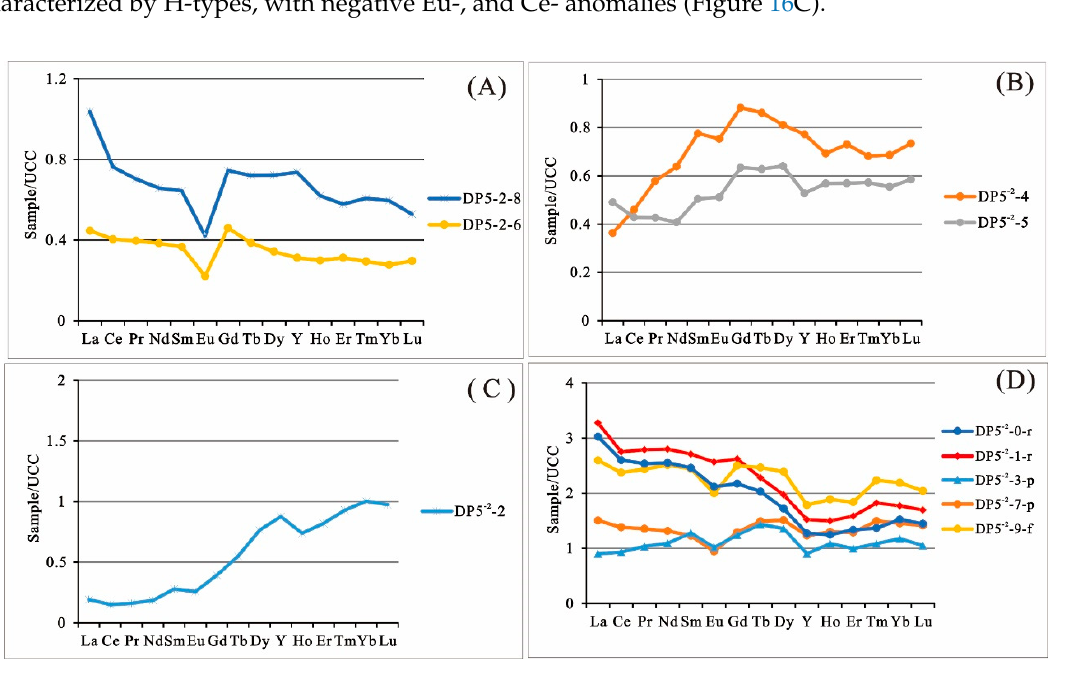
Figure 16. Distribution patterns of rare earth elements and yttrium of the Dongpo Mine samples. REY concentrations are normalized to Upper Continental Crust (UCC) [69]. ( A ) Distribution patterns of rare earth elements and yttrium in Dongpo coals (L-REY). ( B ) Distribution patterns of rare earth elements and yttrium in Dongpo coals (M-and H-REY). ( C ) Distribution patterns of rare earth elements and yttrium in Dongpo coals (H-REY). ( D ) Distribution patterns of rare earth elements and yttrium in roofs, partings and floor from Dongpo